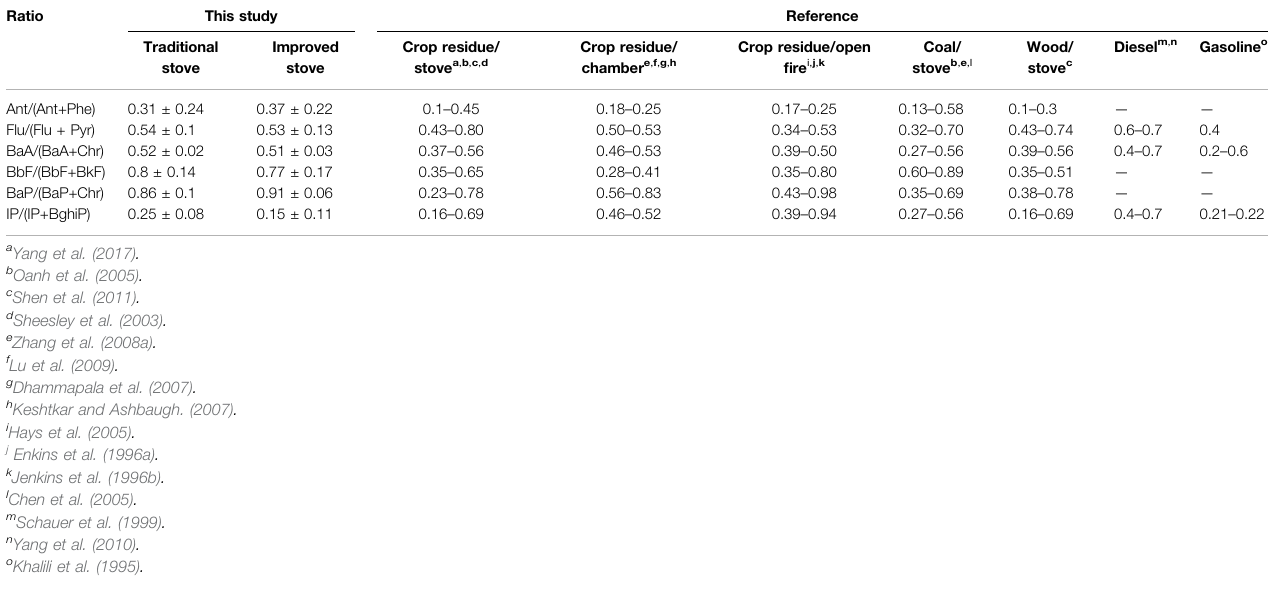
TABLE 3 | PAH isomer ratios found in this study and previous studies. Ratio This study Ant/(Ant +